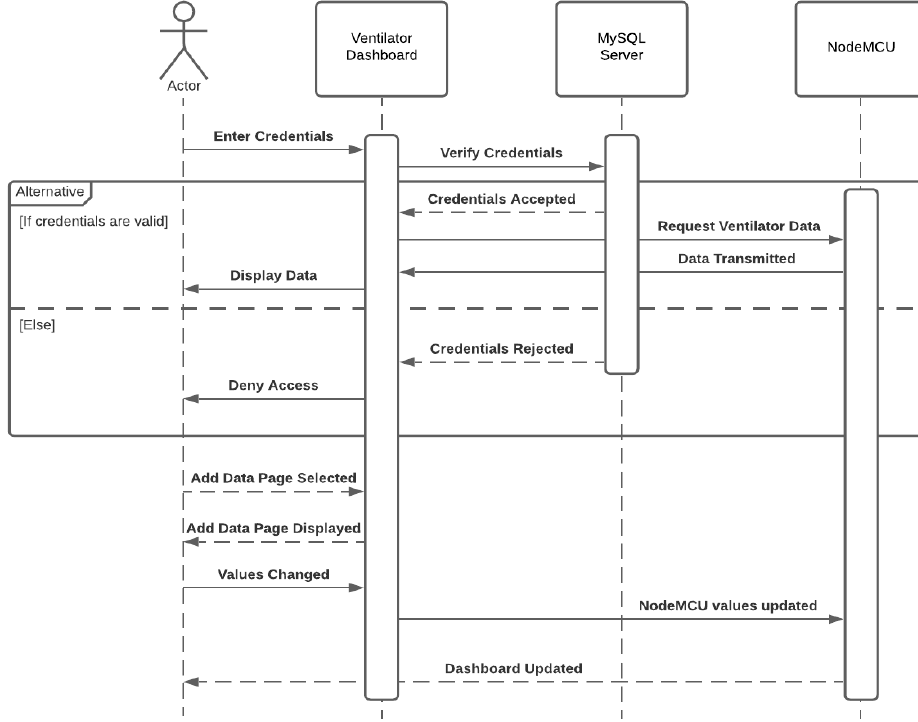
Figure 3. Attack scenario—data manipulating over communication with a ventilator.